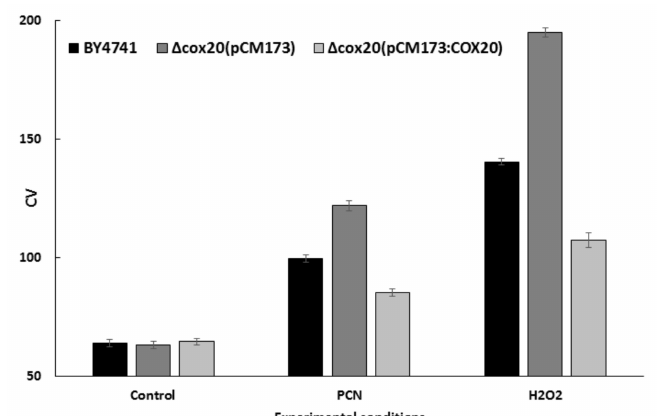
Figure 2. Coe ffi cient of variation analysis of data derived from flow cytometry assays.